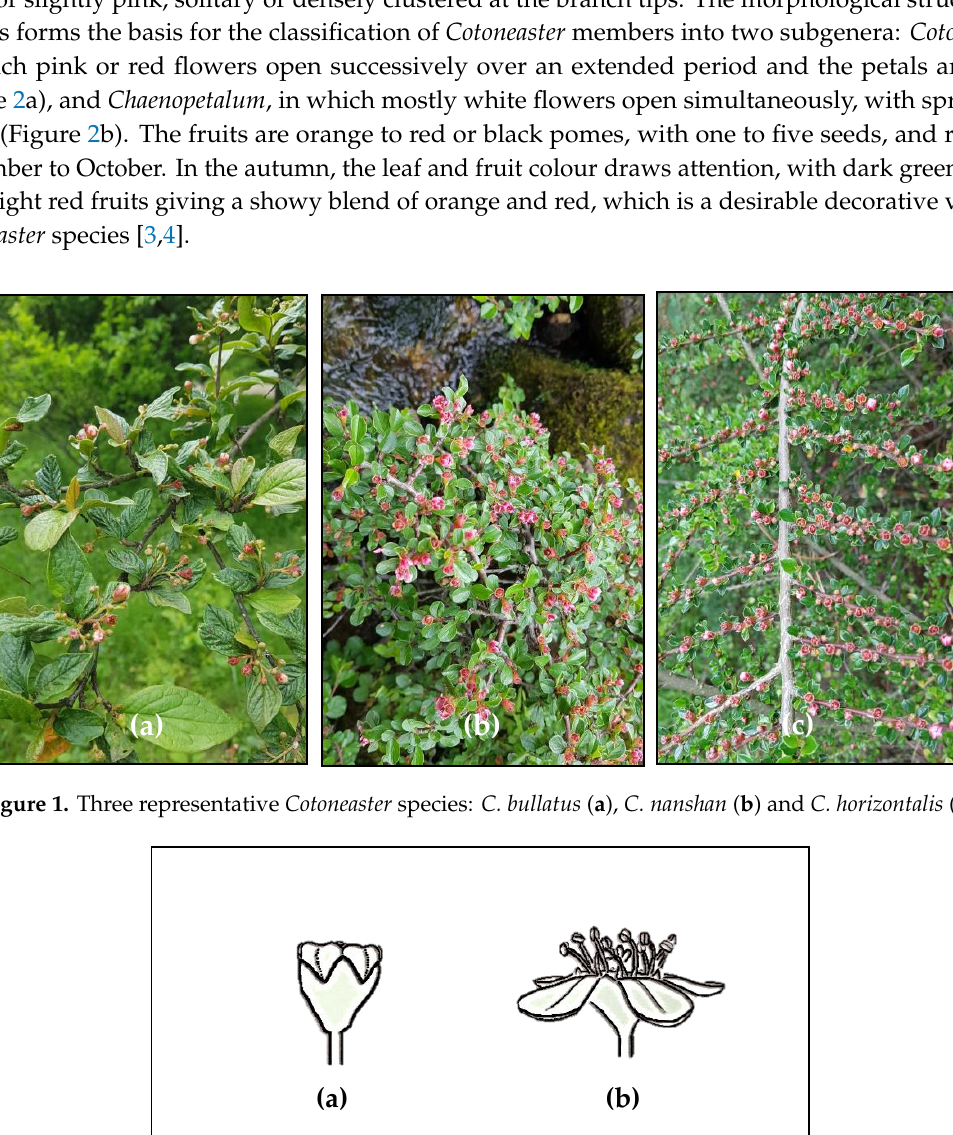
Figure 2. The flower type characteristic of two subgenera: Cotoneaster (a) , and Chaenopetalum (b) (adapted from [4]) .